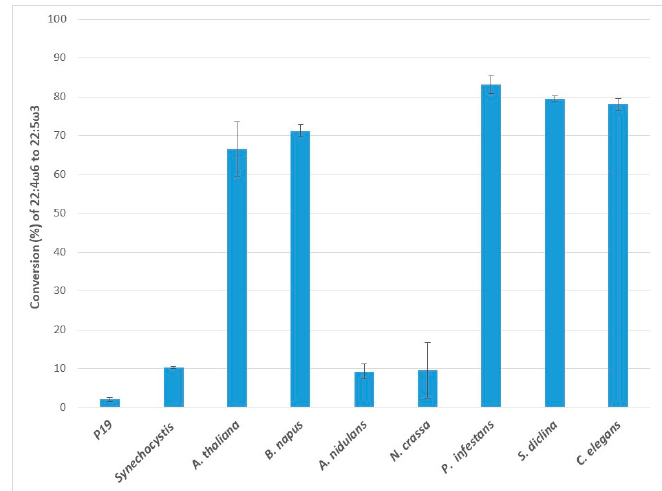
Figure 5. Enzymatic activities of transiently expressed ω 3Ds from various sources in N. benthamiana leaves on 22:4 ω 6 substrate. ω 3D activities were determined by measuring the conversion rate